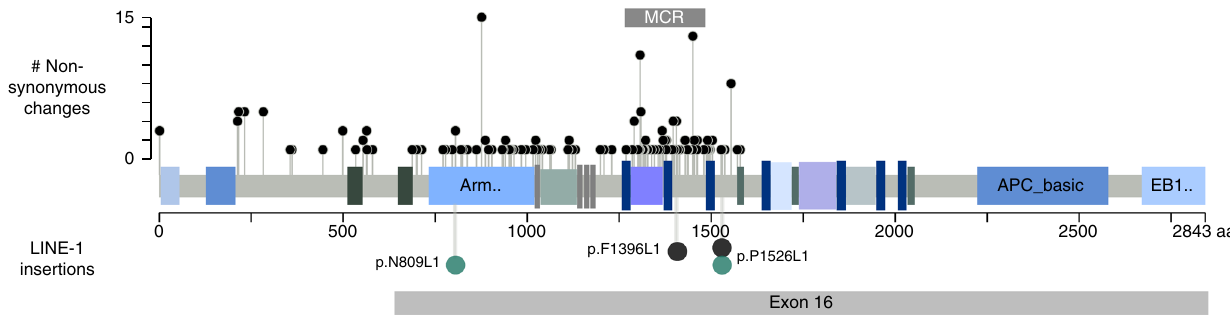
Fig. 4 Distribution of non-synonymous changes and LINE-1 insertions on the linear protein of APC . Non-synonymous changes in 187 MSS CRCs, small lollipops. LINE-1 insertions, larger lollipops. p.N809L1 (c1049.1T) and p.P1526L1 (c310.1T), turquoise lollipops; p.F1396L1 and p.P1526L1 24,25 black lollipops. Figure modi fi ed from cBio cancer genomics portal 59,60